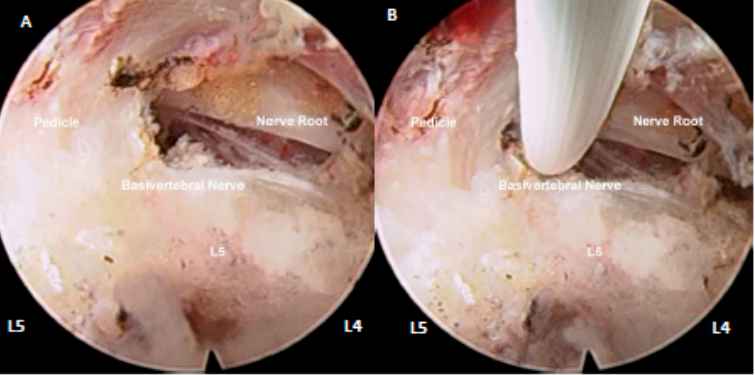
Figure 7. ( A ) Right transforaminal endoscopic approach of L4/5 disc space, under endoscopic